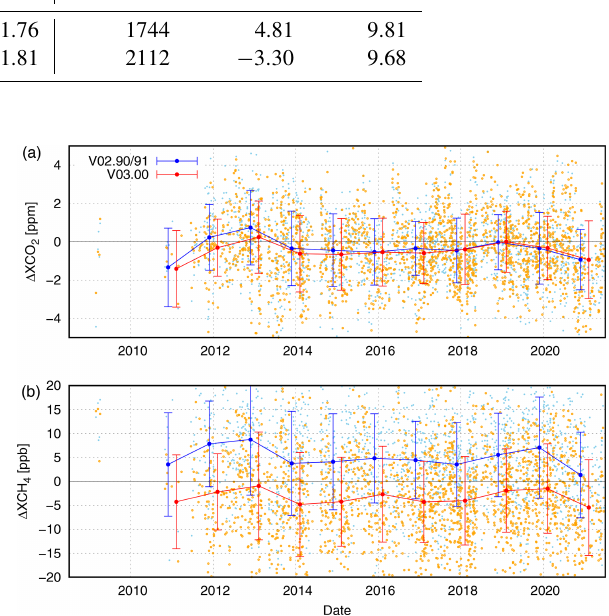
Figure 11. Annual mean differences of the GOSAT L2 product and TCCON GGG2020 in the match-up condition of ± 0 . 1 ◦ for XCO 2 (a) and XCH 4 (b) . The red and blue lines indicate V03.00 and V02.90/91, respectively. The annual mean plots are slightly shifted between V02 and V03 for visibility. Each individual observation from V03.00 and V02.90/91 is plotted as orange and light-blue